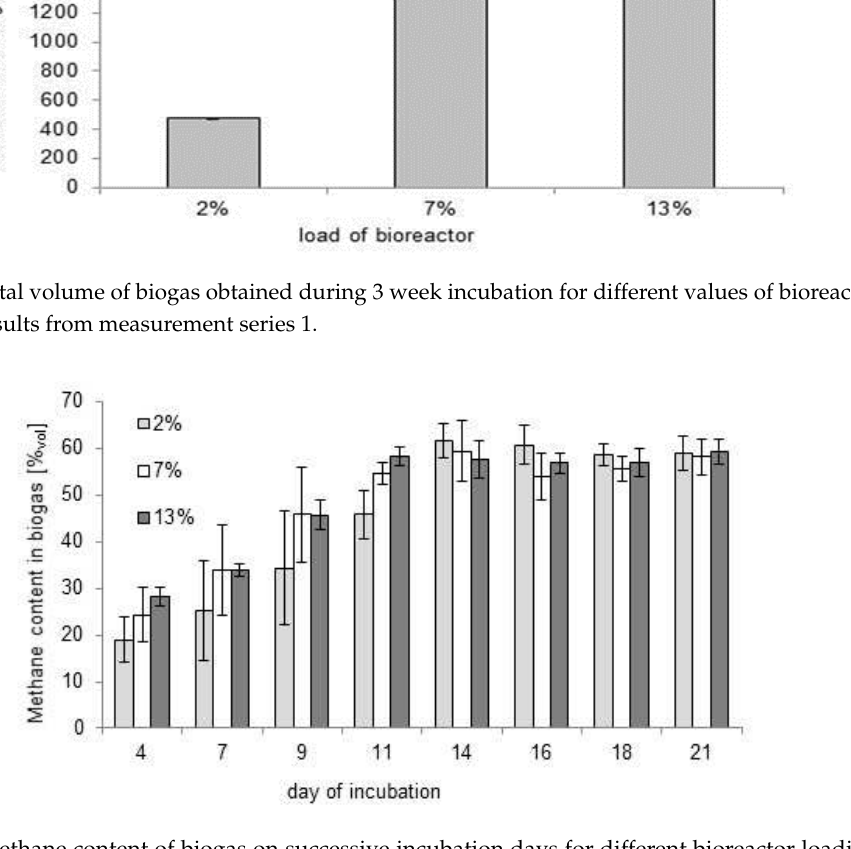
Figure 2. Methane content of biogas on successive incubation days for different bioreactor loading values. Results from measurement series 1.